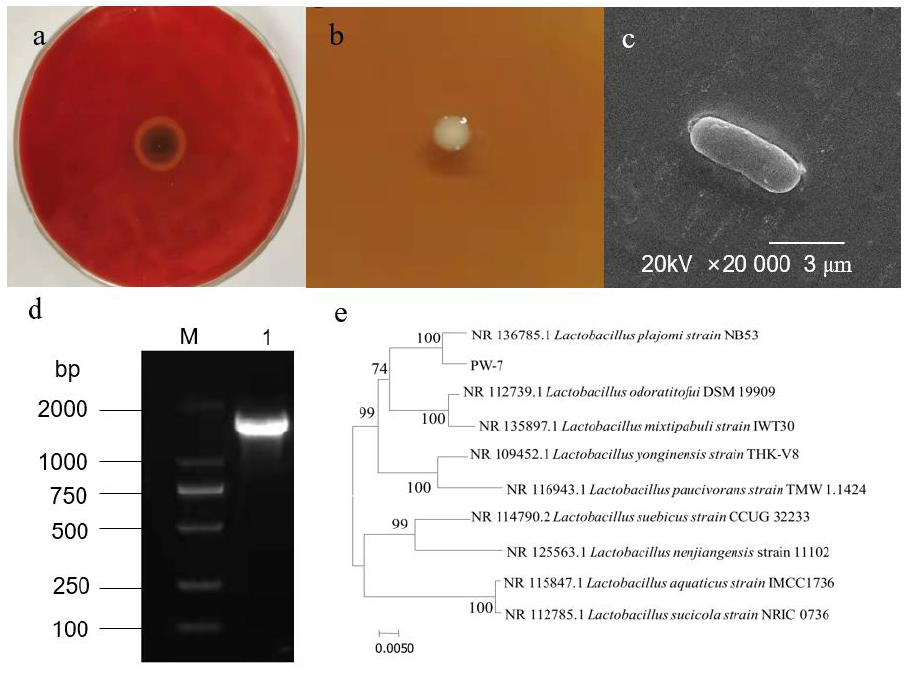
Figure 1. ( a ): Antibacterial effect of PW-7 on H. pylori ; ( b ): colony morphology of strain PW-7; ( c ): scanning electron microscopy of PW-7 morphology; ( d ): agarose gel electrophoresis of 16S rDNA PCR products; M: DNA marker; 1: strain PW-7 16S rDNA PCR amplification product; ( e ): phylogenetic tree based on 16S rDNA gene sequences.